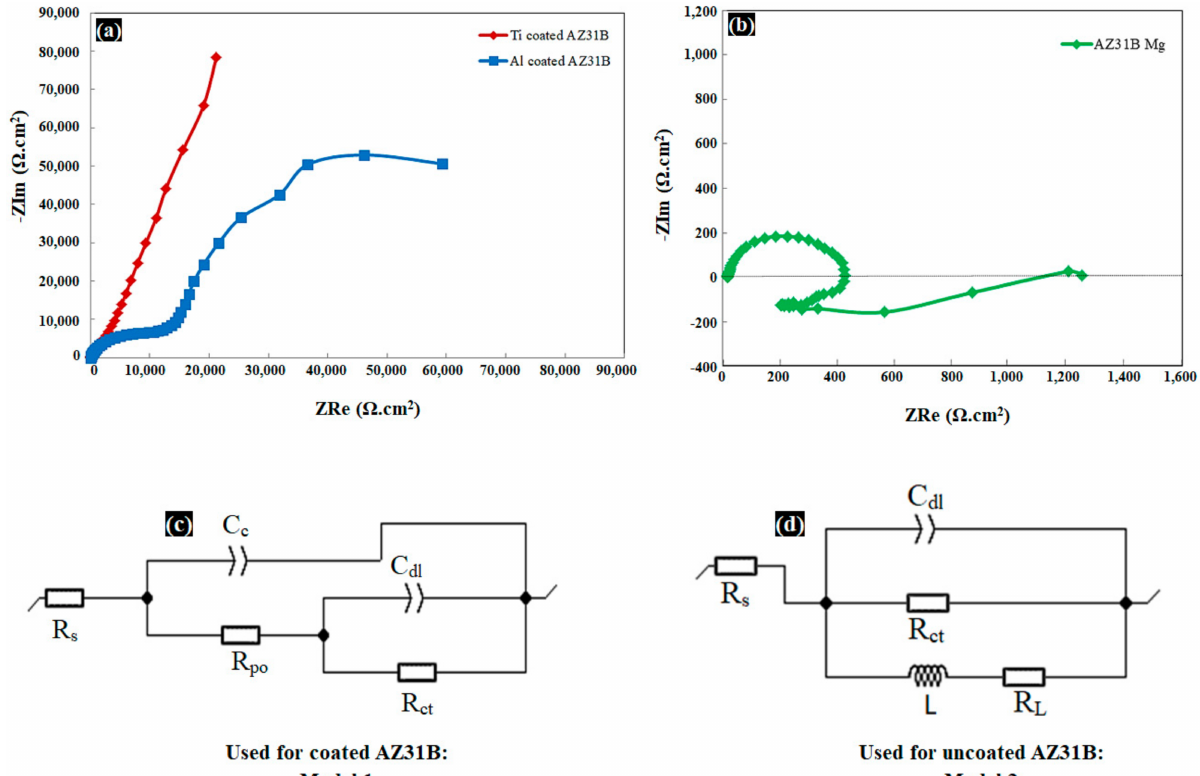
Figure 7. Nyquist plots of ( a , b ) coated and uncoated AZ31B Mg alloy substrates at OCP, electrical equivalent circuits to fit the impedance spectra of ( c ) coated AZ31B Mg alloys (model 1), and ( d ) bare AZ31B Mg alloys (model